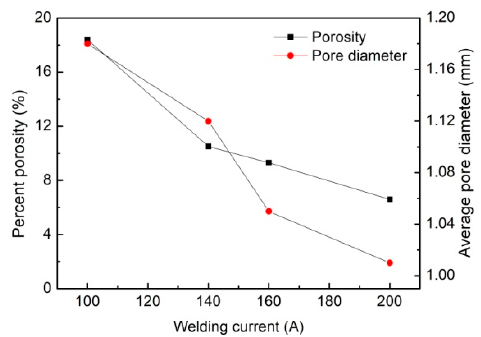
Figure 8. Effect of the welding current on weld percent porosity.